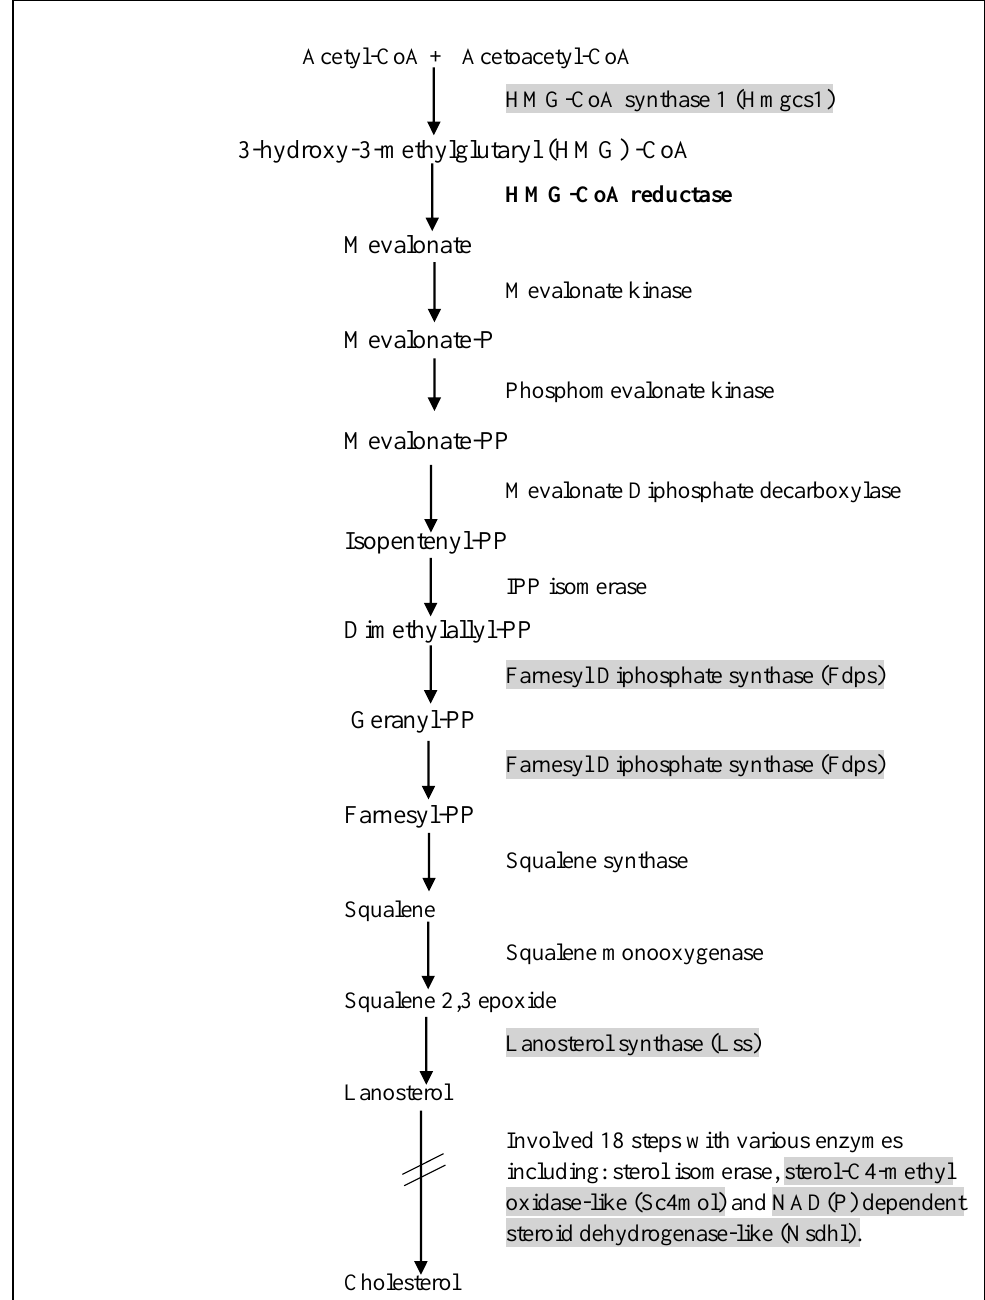
Figure 2. Localization of enzymes involved in the cholesterol biosynthesis pathway. In a previous study by Leow et al. (2011) [32], OPP has downregulated the highlighted genes, while the bold gene exhibited a negative fold change. The figure is modified from Sharpe et al. 2013 [64].